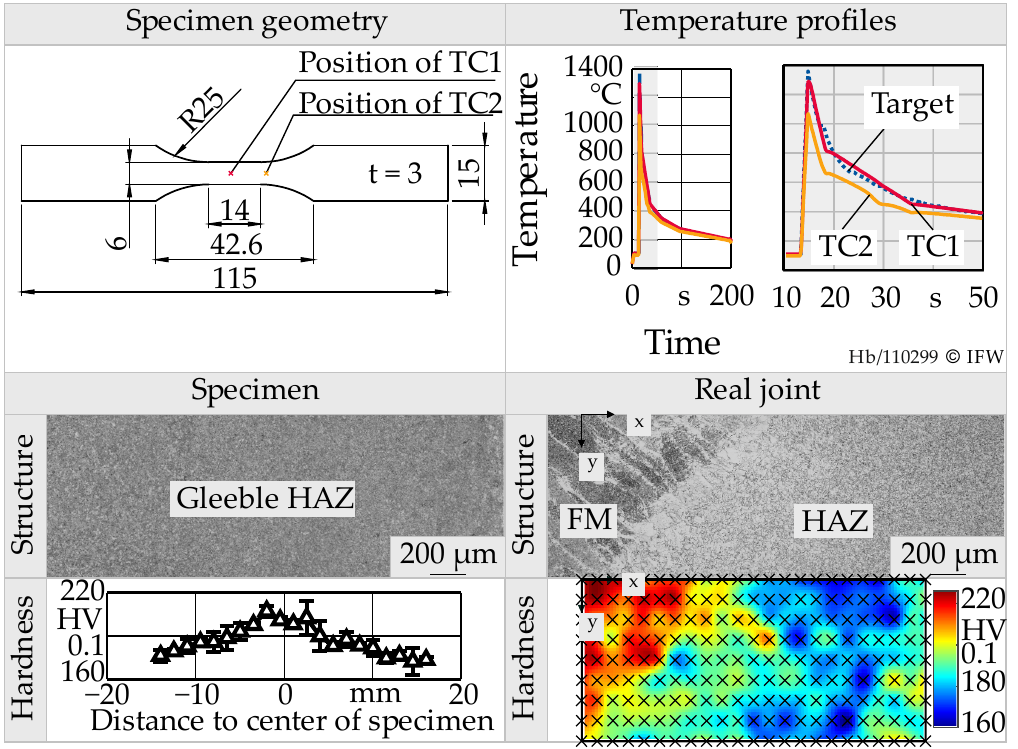
Figure 2. Specimen geometry, thermomechanical simulation, and comparison of hardness and mi- crostructure .